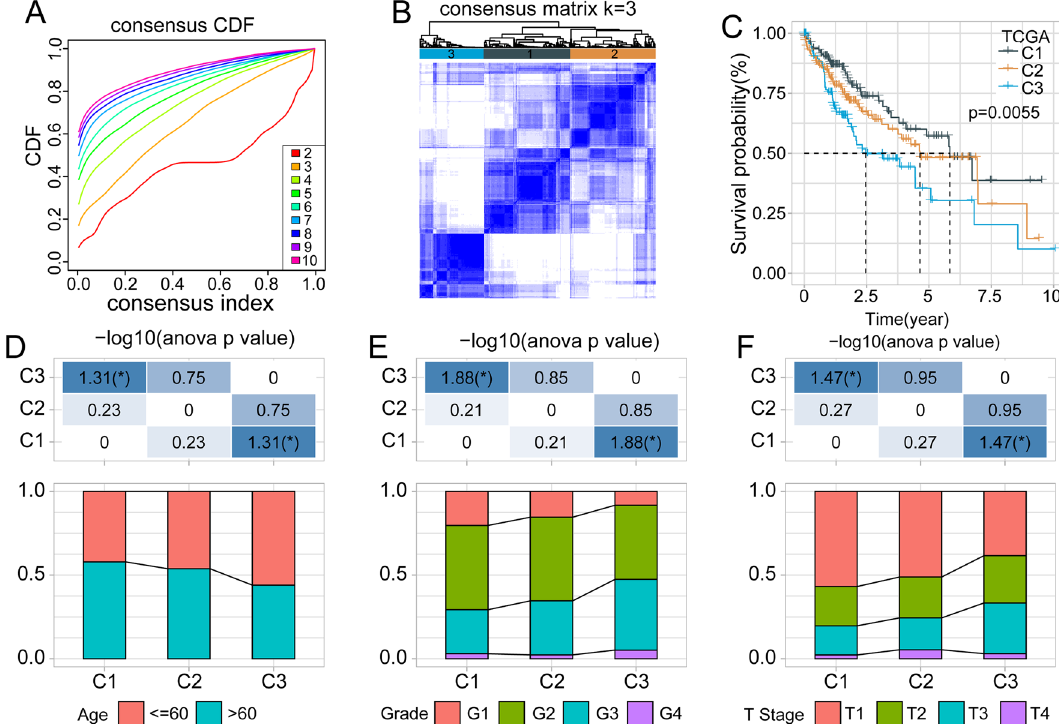
Figure 3. The fatty acid-associated long noncoding RNA (lncRNA) subtypes in the TCGA dataset and their clinical feature. ( A ) Cumulative distribution function (CDF) curves for the TCGA cohort samples. ( B ) Heatmap of the TCGA samples at consensus k = 3. ( C ) Prognostic overall survival (OS) curves for the fatty acid-associated lncRNA subtypes in the TCGA cohort. ( D – F ) Differences in the distributions of different clinical features across the molecular